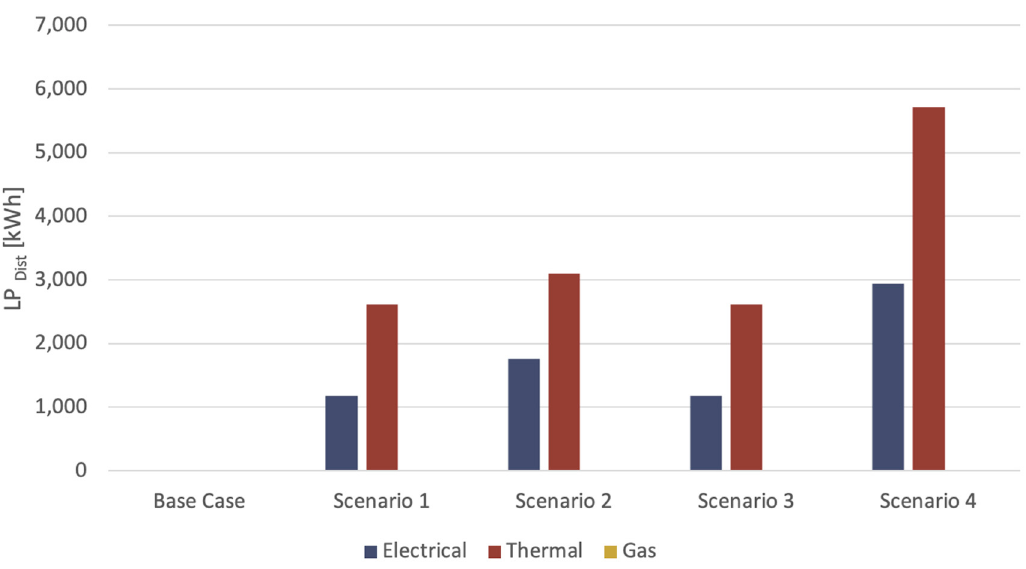
Figure 8. Load Shifting Potential ( LP Dist ) for the Base Case and Scenarios 1–4.